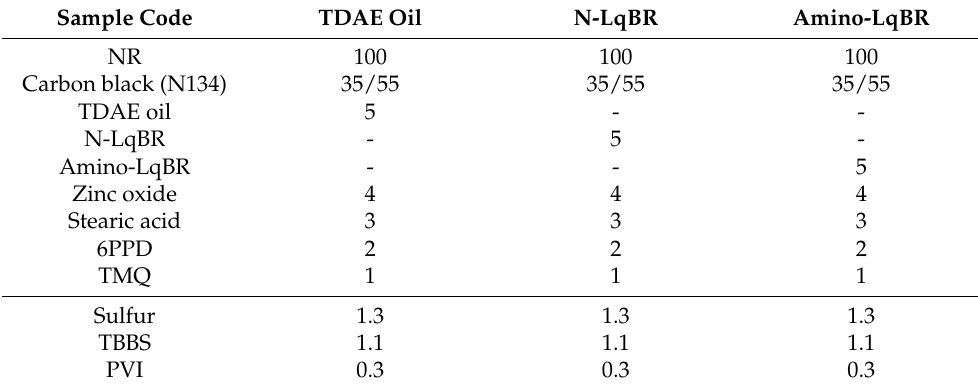
Table 2. Formulation of compounds (unit: